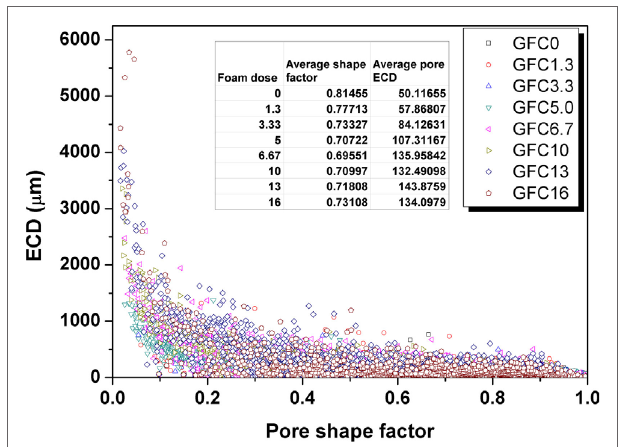
FigUre 6 | Pore shape factor distribution and the relationship with pore sizes in gFcs .